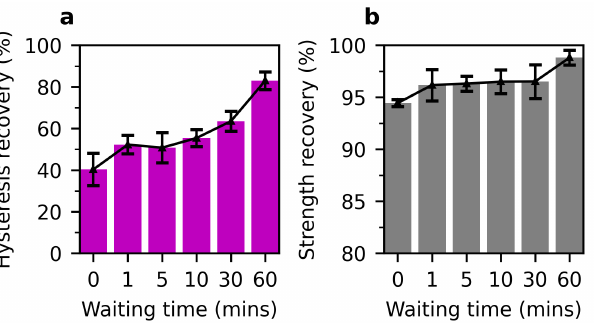
Figure 9. Self-healing test of the hybrid hydrogel of PAH3_14, at a maximum stretch of 3.5, and at ambient temperature. ( a ) Hysteresis recovery, and ( b ) strength recovery, as a function of waiting time. Error bars show the SD; sample size, n = 2 per